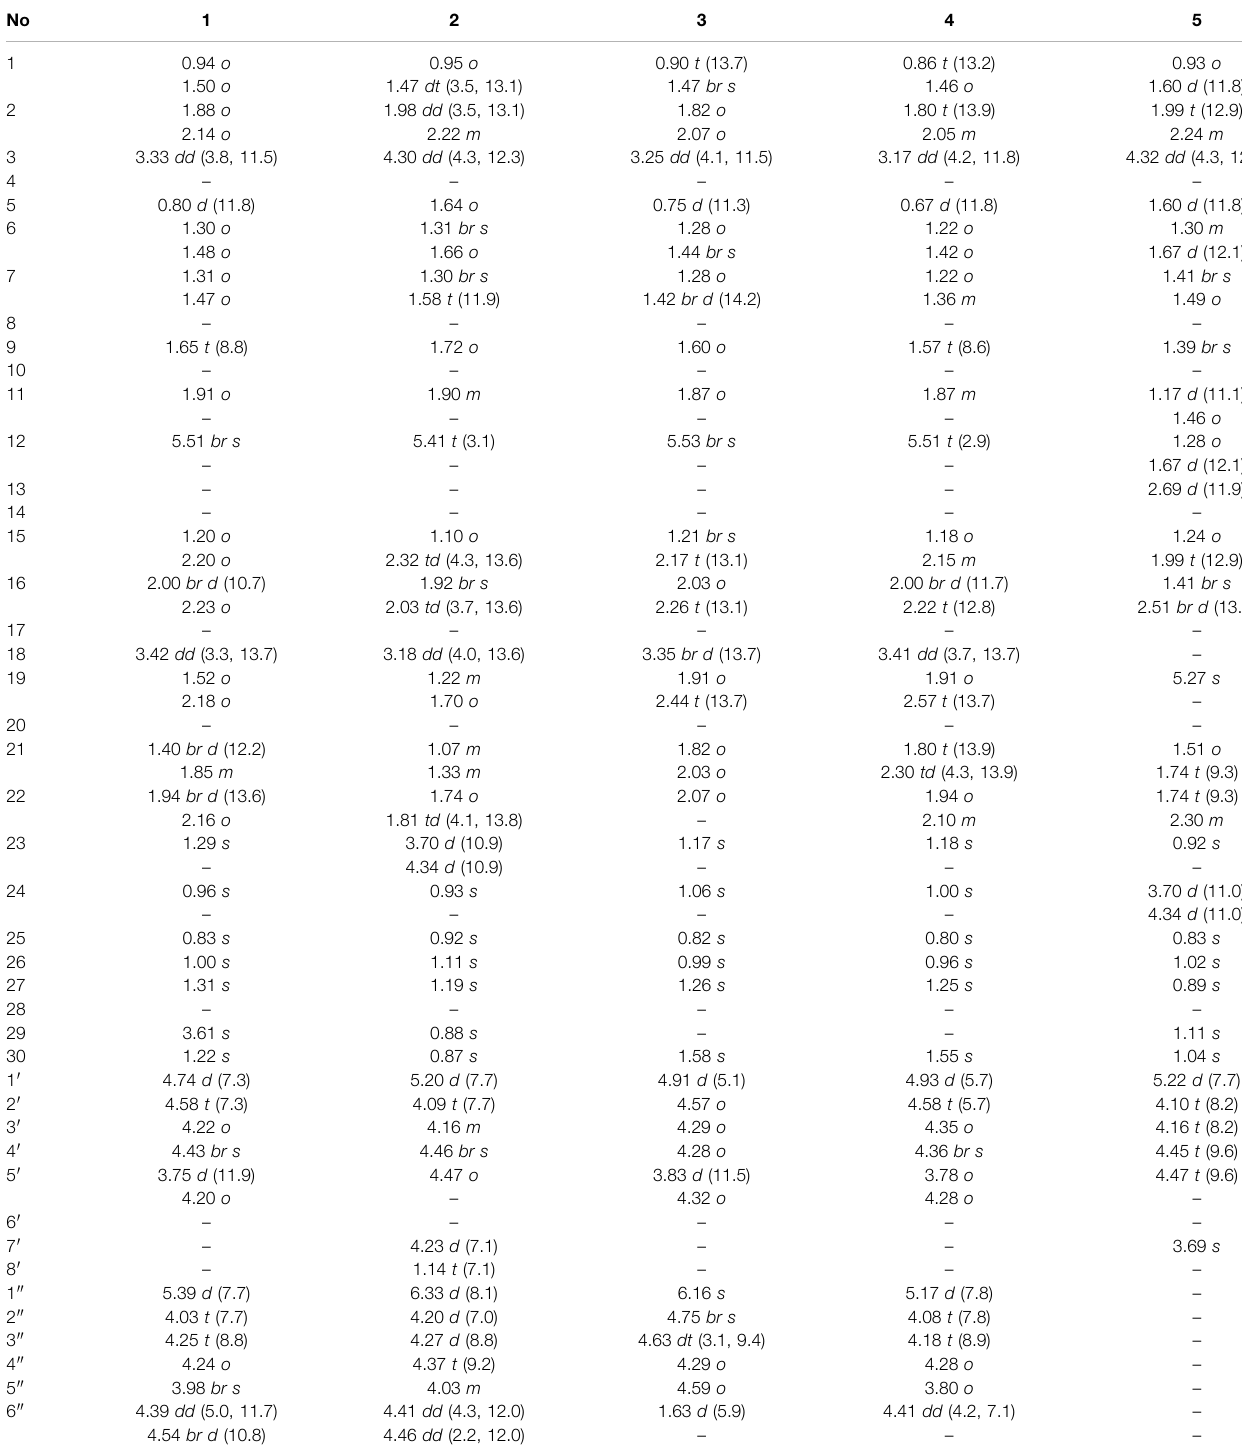
TABLE 2 | 1 H NMR data ( δ ) for compounds 1 – 5 (600, MHz in pyridine- d